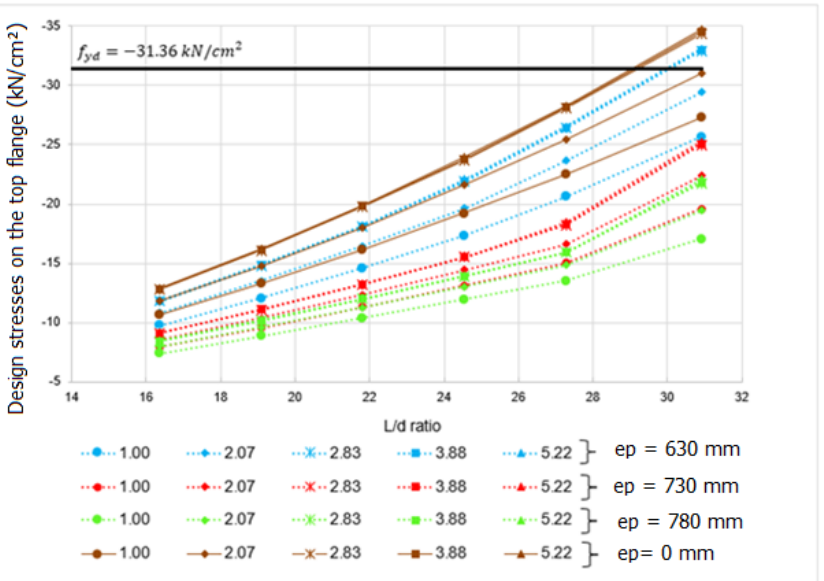
Figure 15. Graph of design stresses on the top flange of the